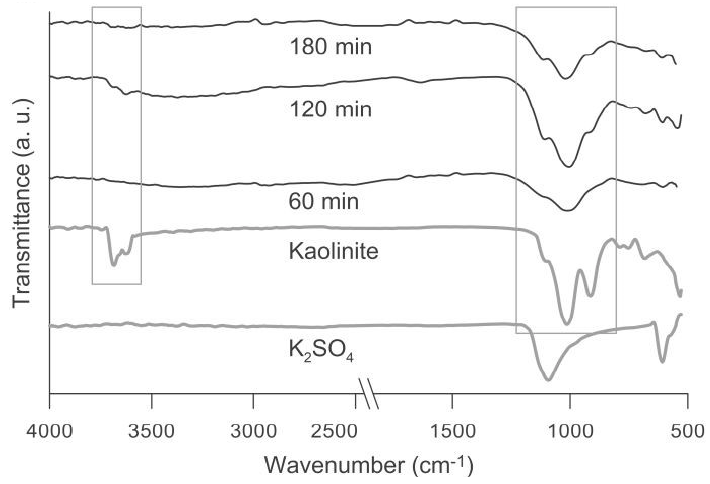
Figure 1. FTIR spectra of kaolinite-K 2 SO 4 samples milled at 700 rpm with different milling times.